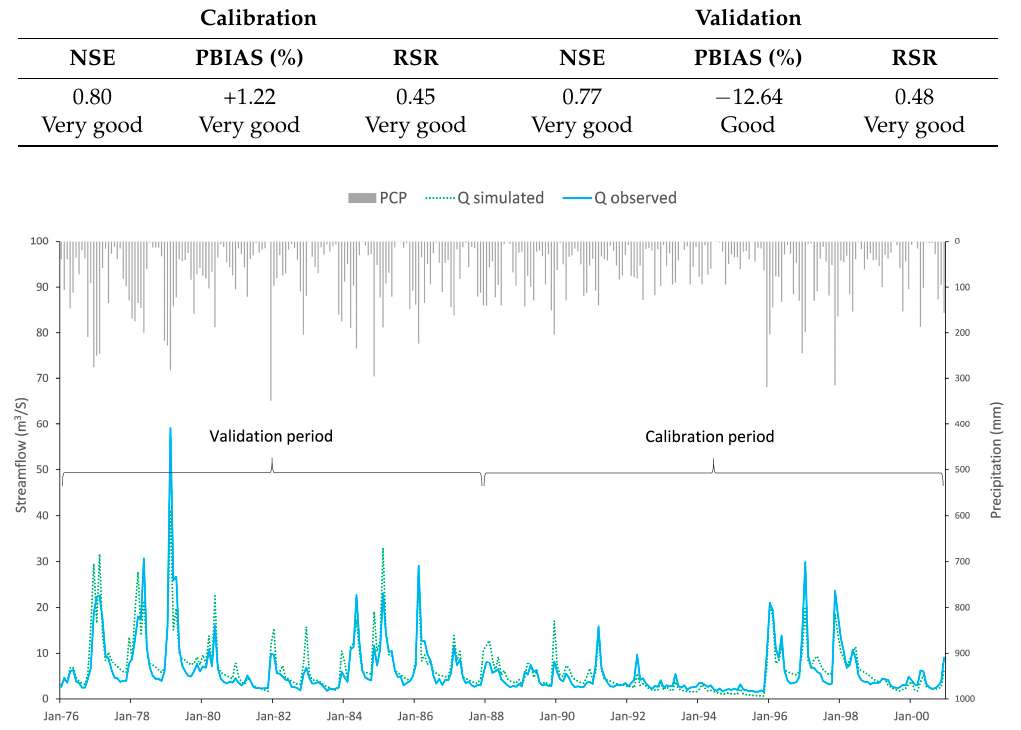
Table 5. Normalised performance indicators obtained.